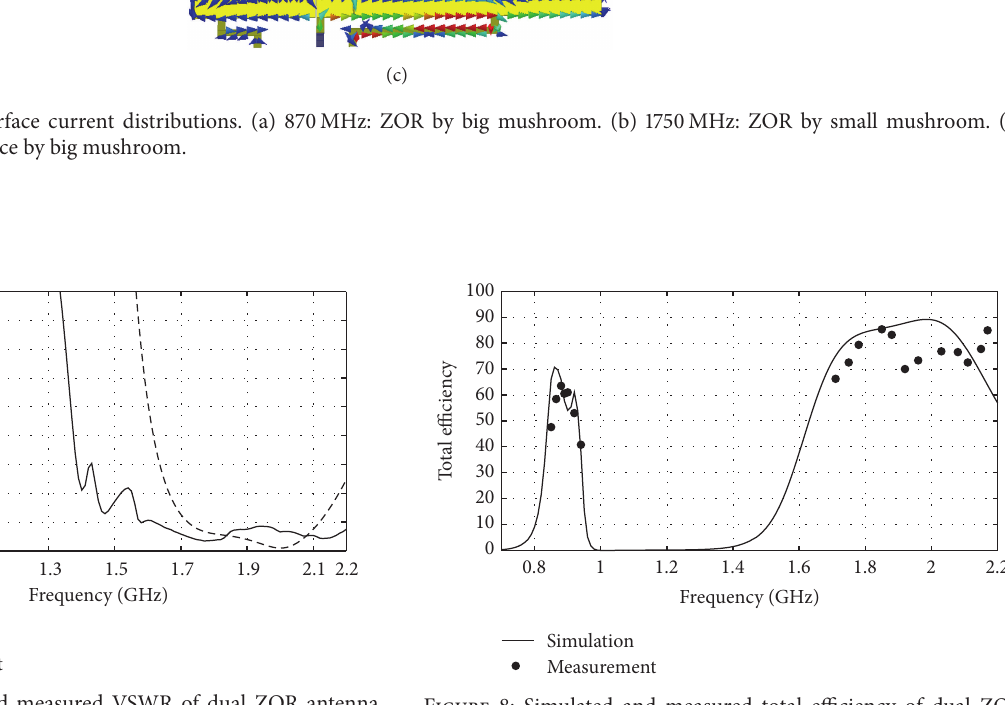
Figure 8: Simulated and measured total efficiency of dual ZOR antenna with